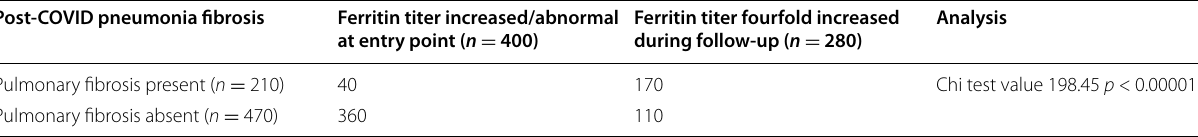
680) and follow-up and its correlation with post-COVID lung fibrosis =